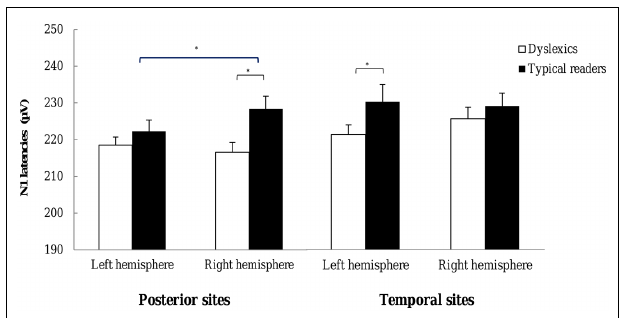
FIGURE 6 | N1 latencies observed for each hemisphere. Open bars refer to the N1 latencies of dyslexic readers and filled bars to the N1 latencies of typical readers. For each plot latencies are averaged across the most posterior P7–P8, P5–P6, PO7–PO8, and O1–O2 pairs (left) and across the most temporal P9–P10 andTP7–TP8 electrode pairs (right). * p <